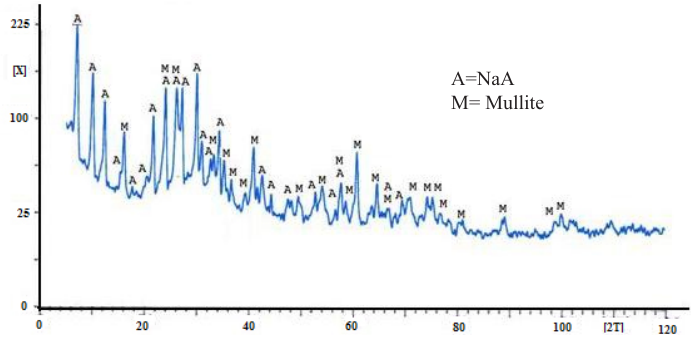
Fig. 6. XRD patterns the membrane from